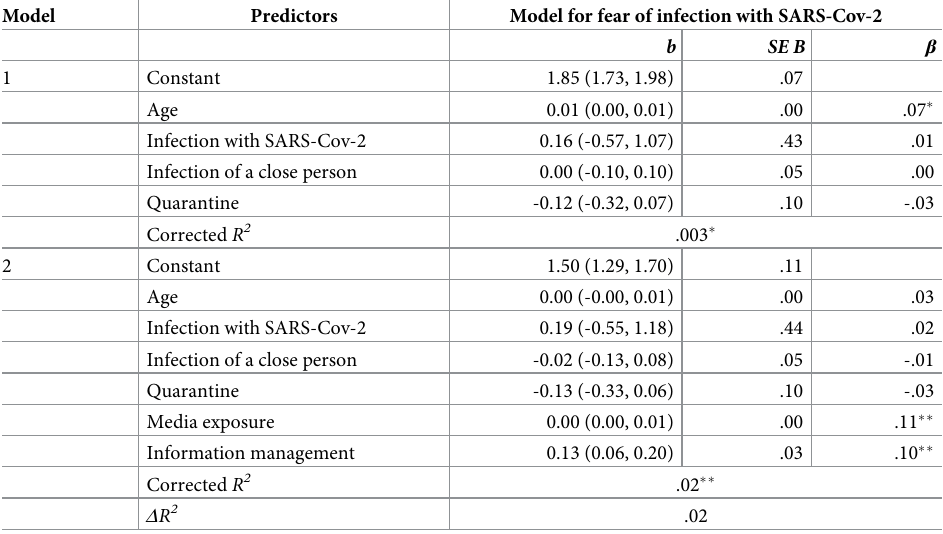
Table 4. Linear model of predictors of infection with SARS-Cov-2, with 95% confidence